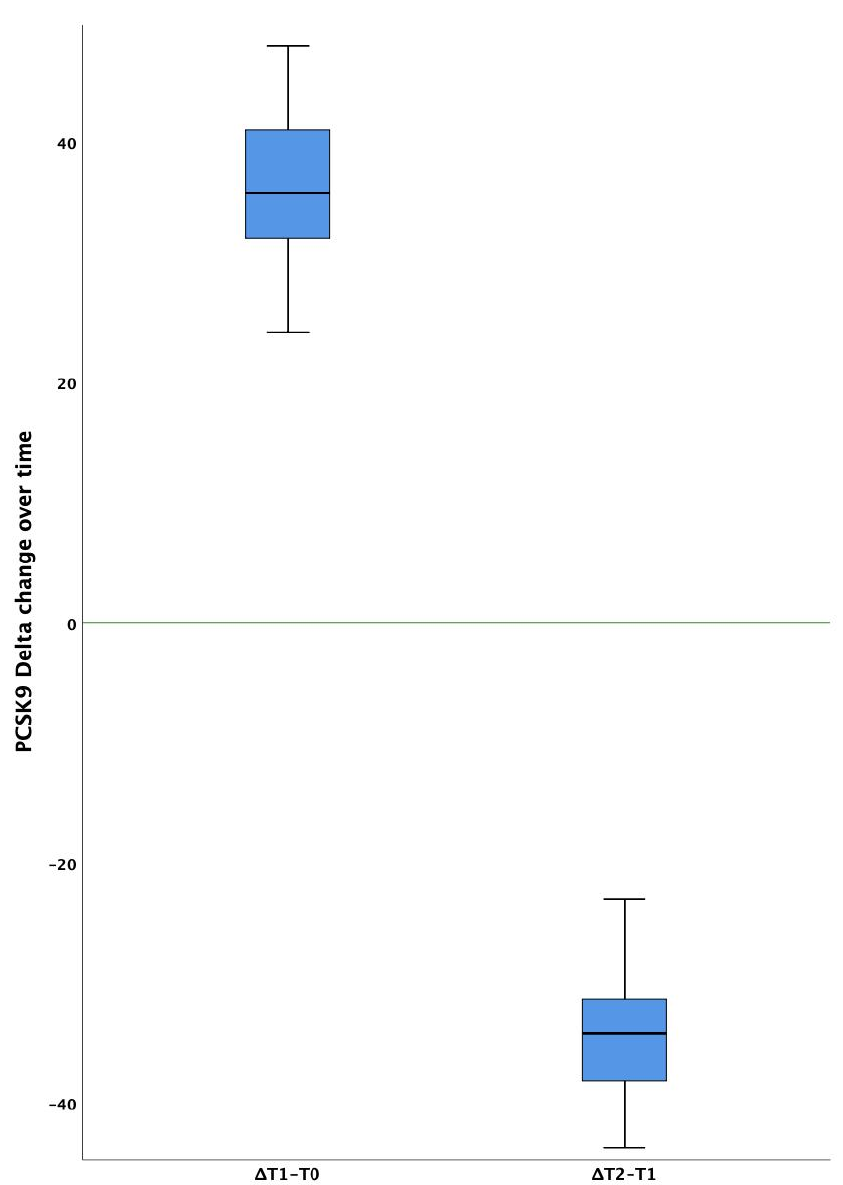
Figure 2. Box and whisker plots describing PCSK9 circulating levels delta change over time. Solid horizontal lines = median values; error bars = 95% Confidence intervals; Shaded area = Interquartile range. Median baseline value is depicted by the green line.